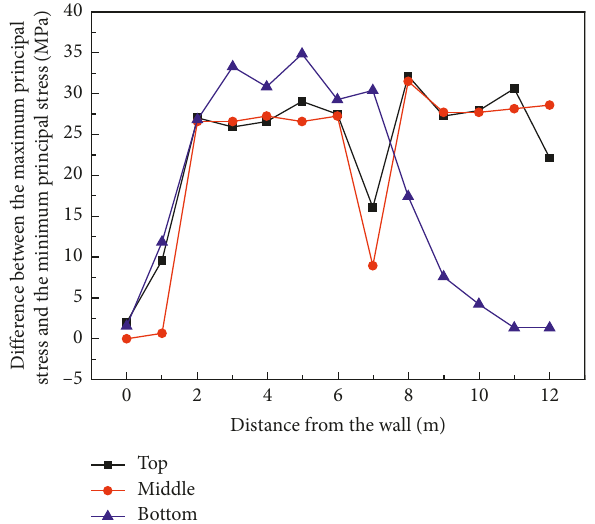
Figure 5: Curve of maximum and minimum principal stresses of different layers of 1.5m thick medium-hard layer coal